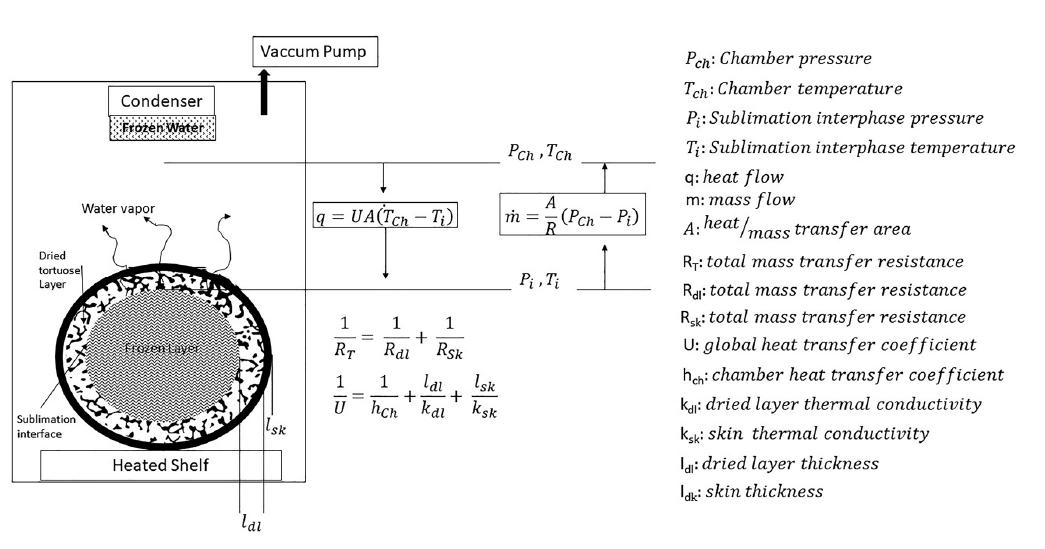
Figure 1. Like-berry-fruit freeze-drying system and its basic phenomenological description.